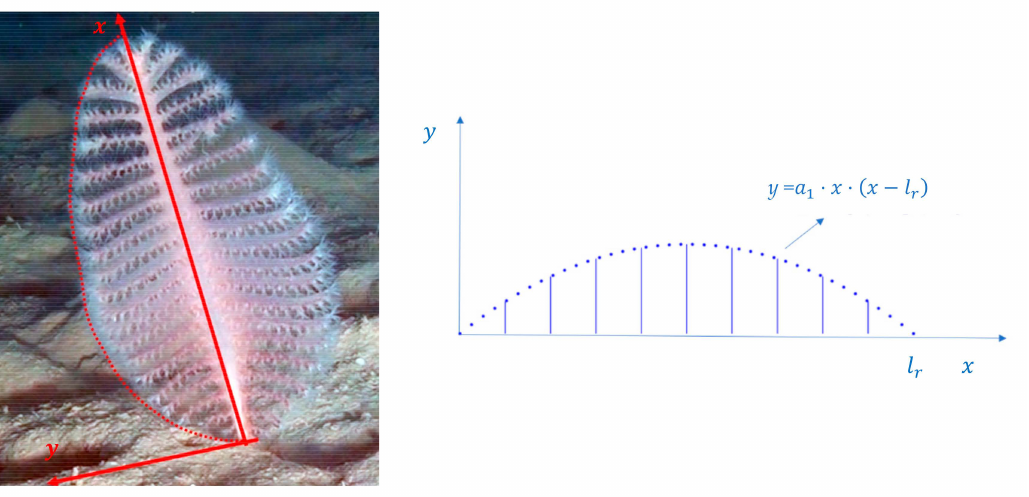
Figure 4. 2D outline of Pennatula rubra .